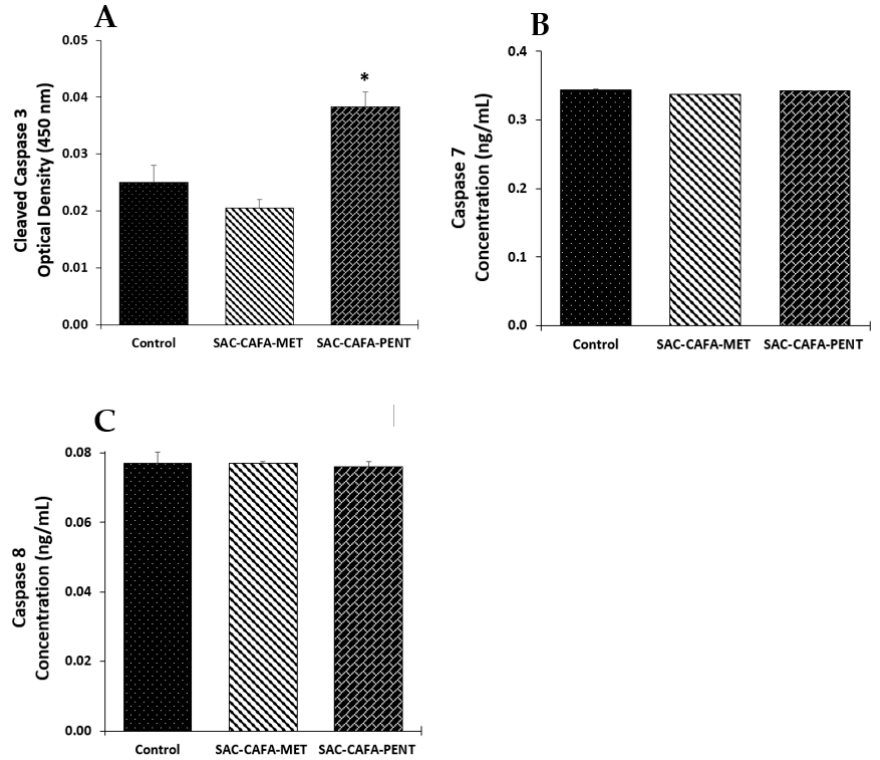
Figure 2. Levels of caspases in SW480 cells 48 h post-treatment with SAC-CAFA-MET (124.2 µ M) and SAC-CAFA-PENT (118 µ M) or 1% DMSO (control): ( A ) caspase-3; ( B ) caspase-7; ( C ) caspase-8. Data are presented as the mean ± SE of three independent experiments (* p < 0.05). Optical density is directly proportional to the quantity of the protein.